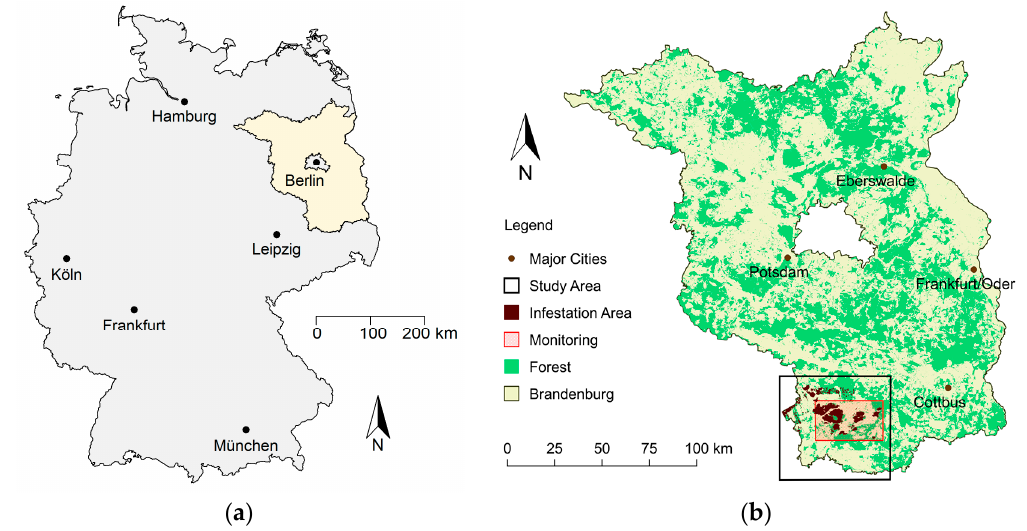
Figure 1. The state of Brandenburg in northeast Germany ( a ) and the infestation area with heavy foliage loss caused by Diprion pini L. in 2016 in the south of the state (in dark brown, ( b )). The green shading in ( b ) represents the total forest cover of Brandenburg; the study area is marked by a square frame and a smaller area for demonstration of monitoring practice by a red rectangle.